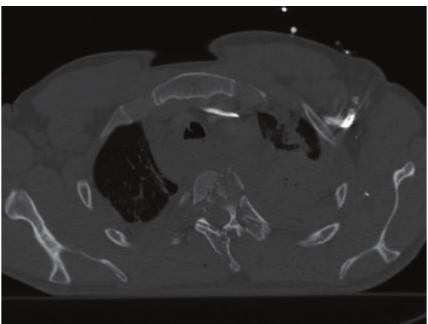
Figure 17: Thoracic vertebral fracture in a patient who suffered a car crash. Axial MDCT in bone window. A comminuted thoracic vertebral fractureisdepictedwithmultiplefragmentsofthebodyandspinousprocessesofthethirdthoracicvertebra.Hemomediastinum,hemothorax, and pulmonary contusions are also associated.